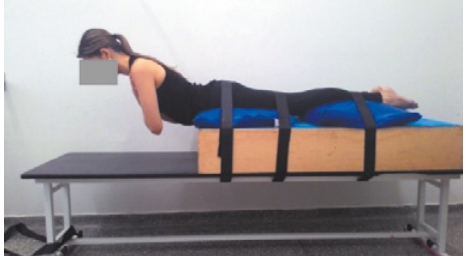
Figure 2. Execution of the Biering-Sorensen test.